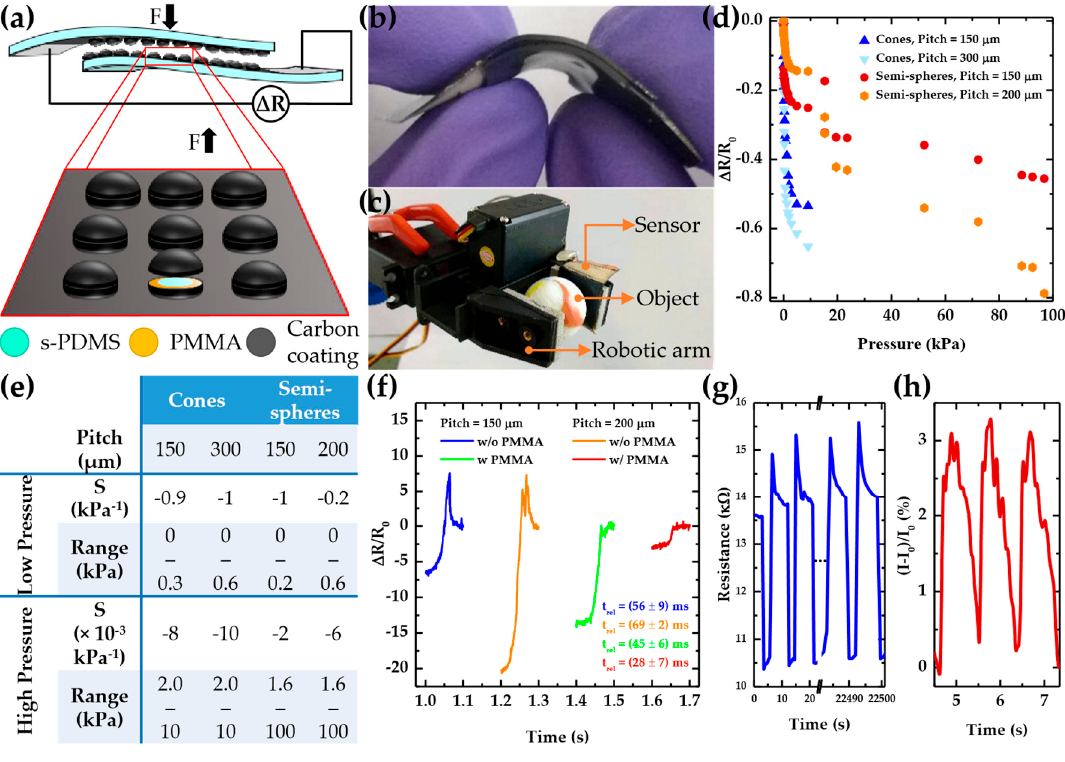
Figure 3. Electrical characterization of e-skin sensors. ( a ) Illustration of a semi-spheres sensor. ( b ) Photograph of a sensor under bending. ( c ) Photograph of a semi-spheres sensor placed in a robotic arm. ( d ) Relative resistance change for each sensor. ( e ) Sensitivity of the sensors from ( d ) for the low and high pressure regions. ( f ) Relaxation time of micro-domes sensors with (w) and without PMMA (w/o). The values indicated correspond to average values ± standard deviation of 7 measurements. ( g ) Resistance change throughout time during the cyclic grasping and releasing of an object by a robotic arm with a semi-spheres sensor. ( h ) Relative current change throughout time during the detection of the radial artery blood pressure wave (at the wrist) with a micro-cones